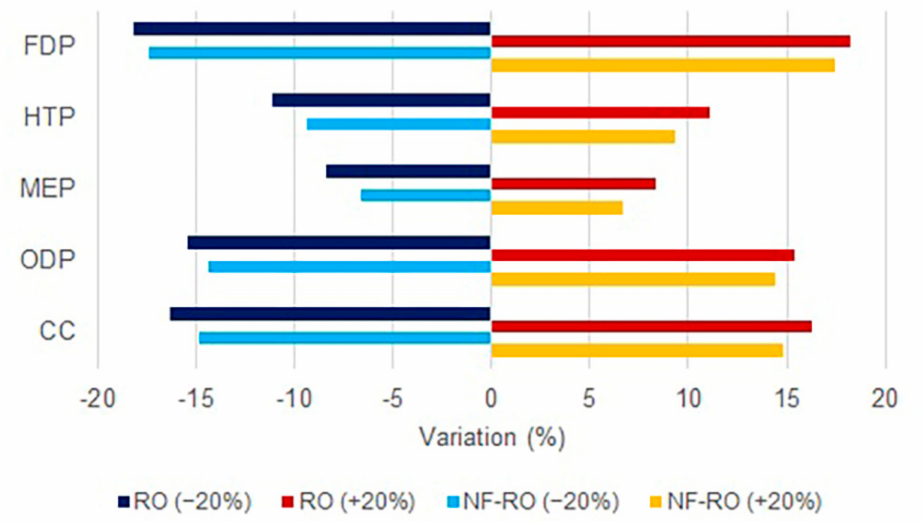
Figure 13. Sensitivity analysis for cases 4 and 5 based on the impacts of the electricity